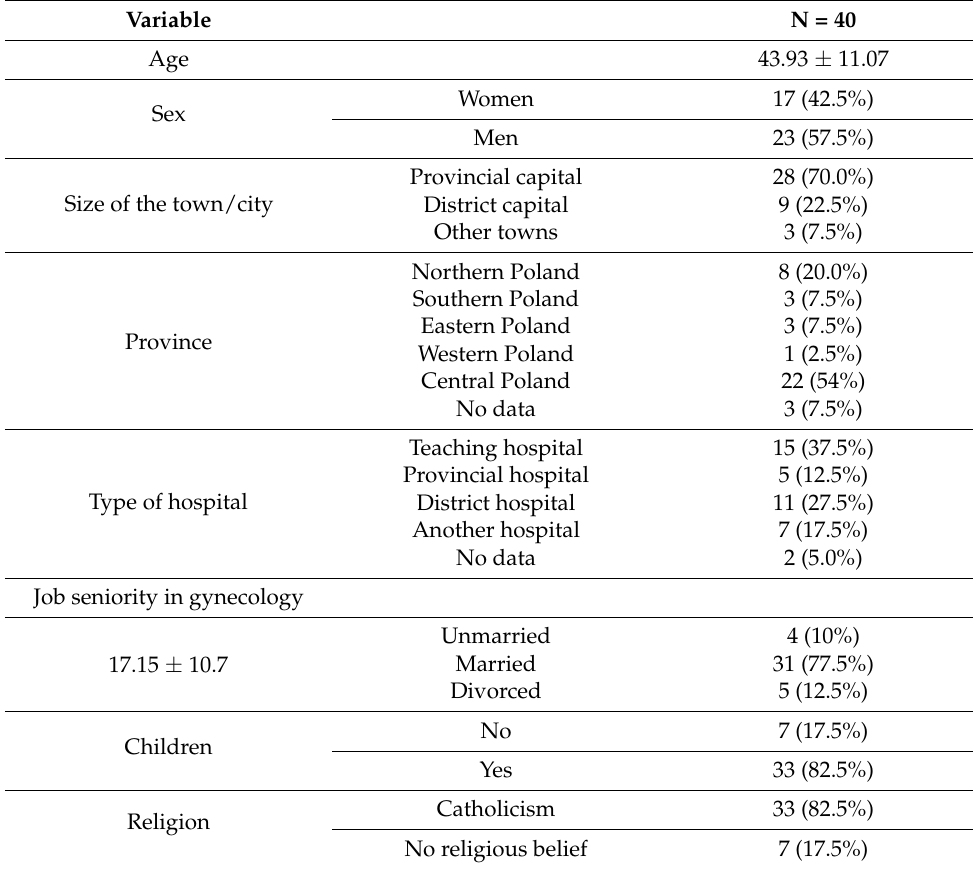
Table 1. General description of the group.